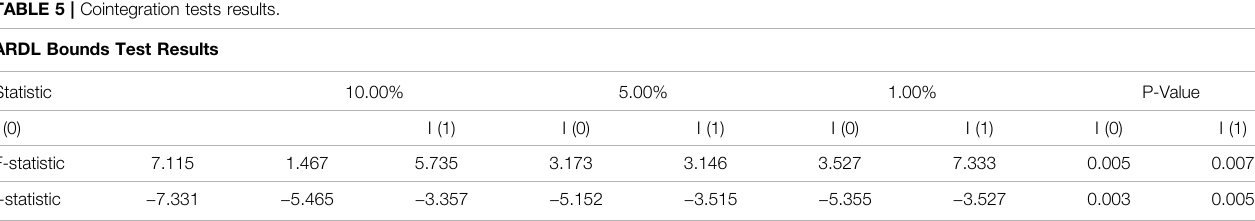
TABLE 5 | Cointegration tests results.